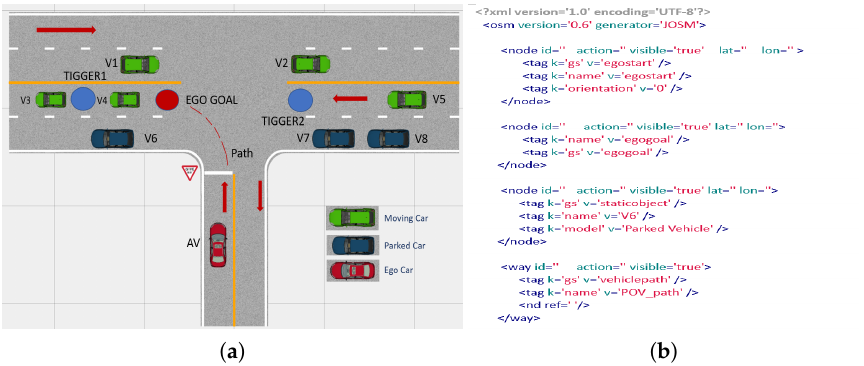
Figure 9. Defining example scenario using GeoScenario. ( a ) Graphical representation of the scenario. ( b ) Part of the corresponding GeoScenario XML